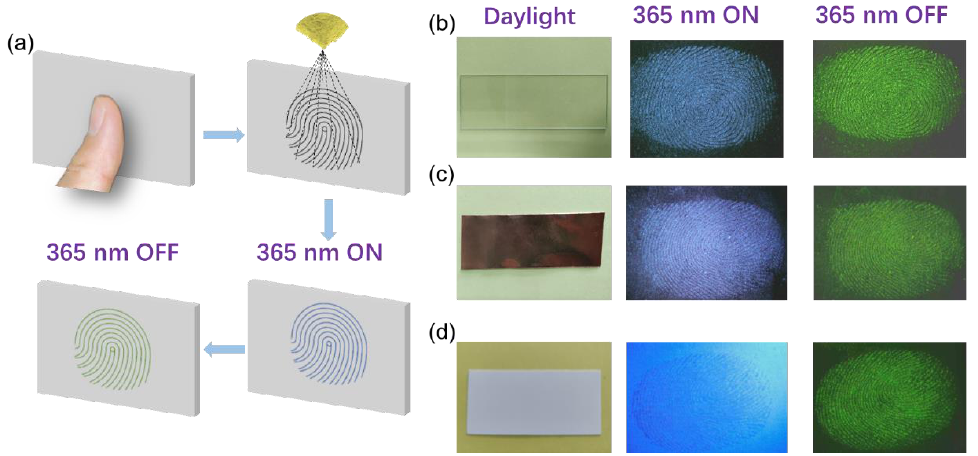
Figure 5. ( a ) fingerprint identification process of fingerprint morphology; ( b ) transparent, ( c ) opaque, and ( d ) fluorescent materials under different light conditions.